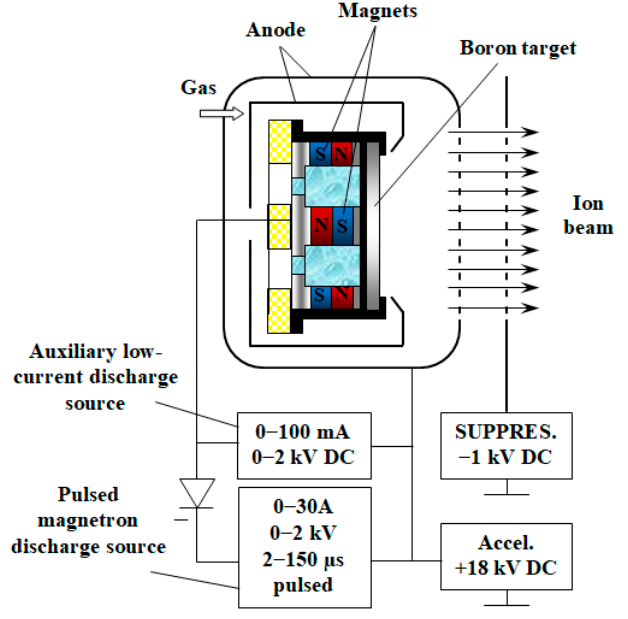
Figure 3. Schematic diagram of a magnetron sputtering system with a pure boron cathode and ion beam extraction [29].